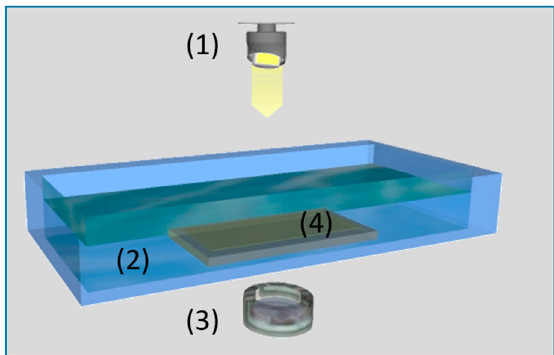
Figure 3. Setup for transmission experiments on precipitating polymer solutions.